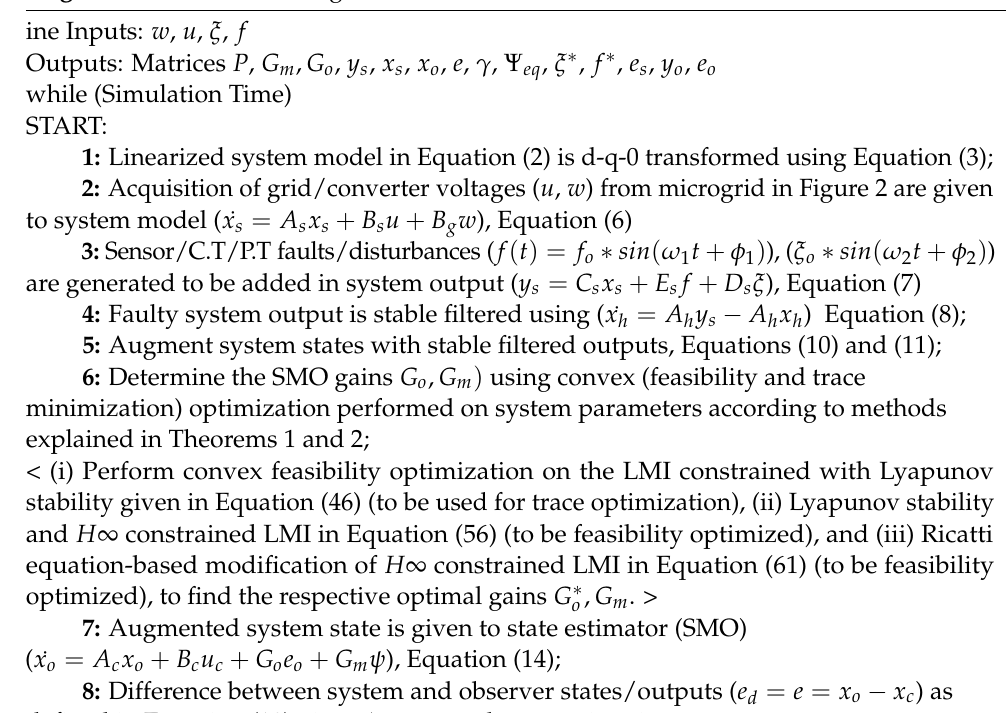
Algorithm 1. Procedure